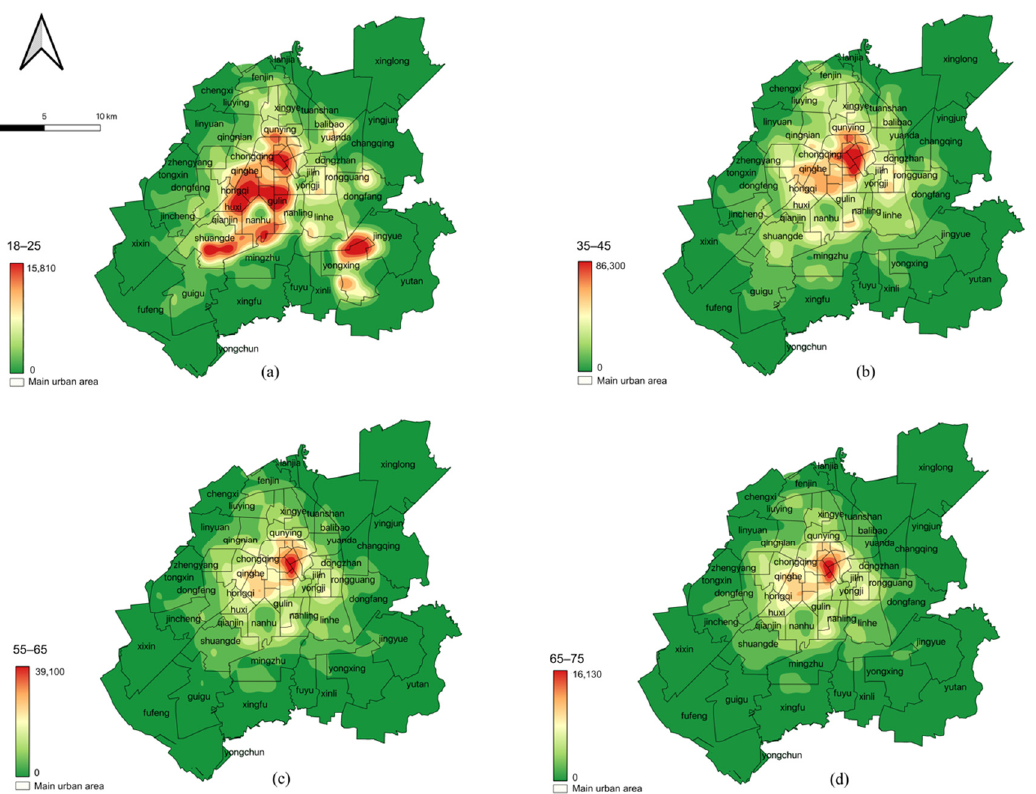
Figure 6. Spatial distribution of population activity intensity by age group. ( a ) 18–25; ( b ) 35–45; ( c ) 55–65; ( d ) 65–75.